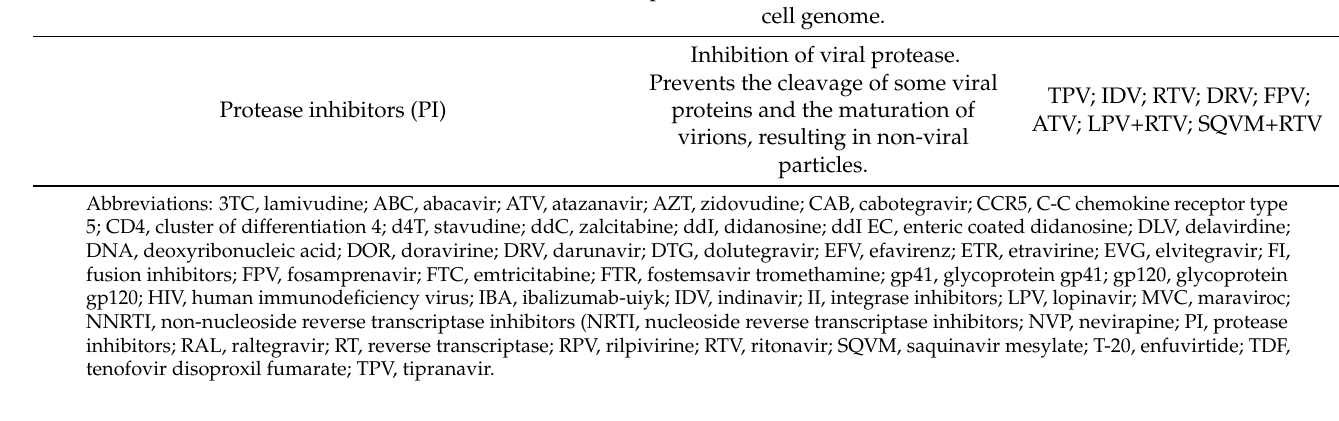
Inhibition of viral protease. Prevents the cleavage of some viral proteins and the maturation of virions, resulting in non-viral